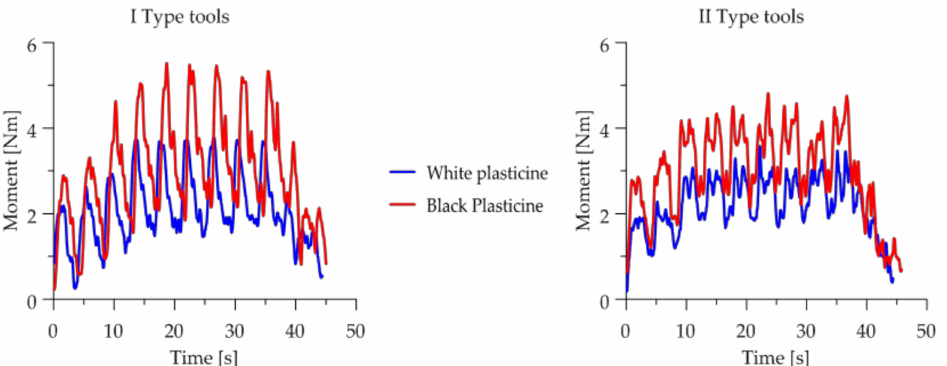
Figure 14. Tool roll torque change charts during